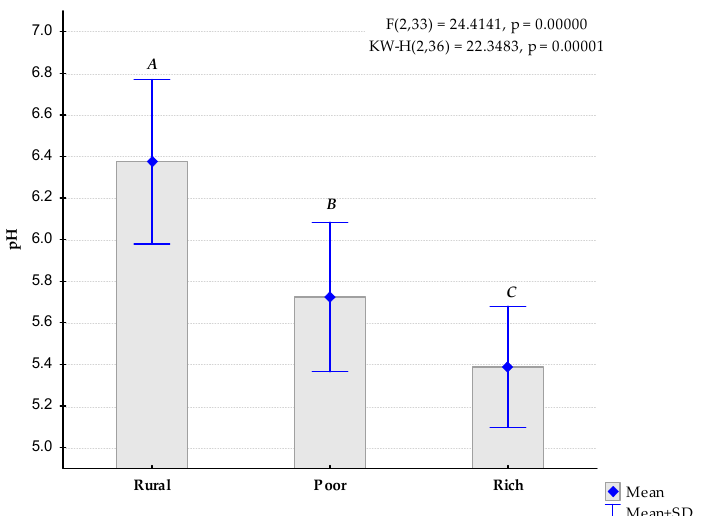
Figure 4. Comparison of mean values of pH between the three study areas. Letters indicate statis- tically different homogenous groups according to the post-hoc LSD-Fisher test ( p <0.05).